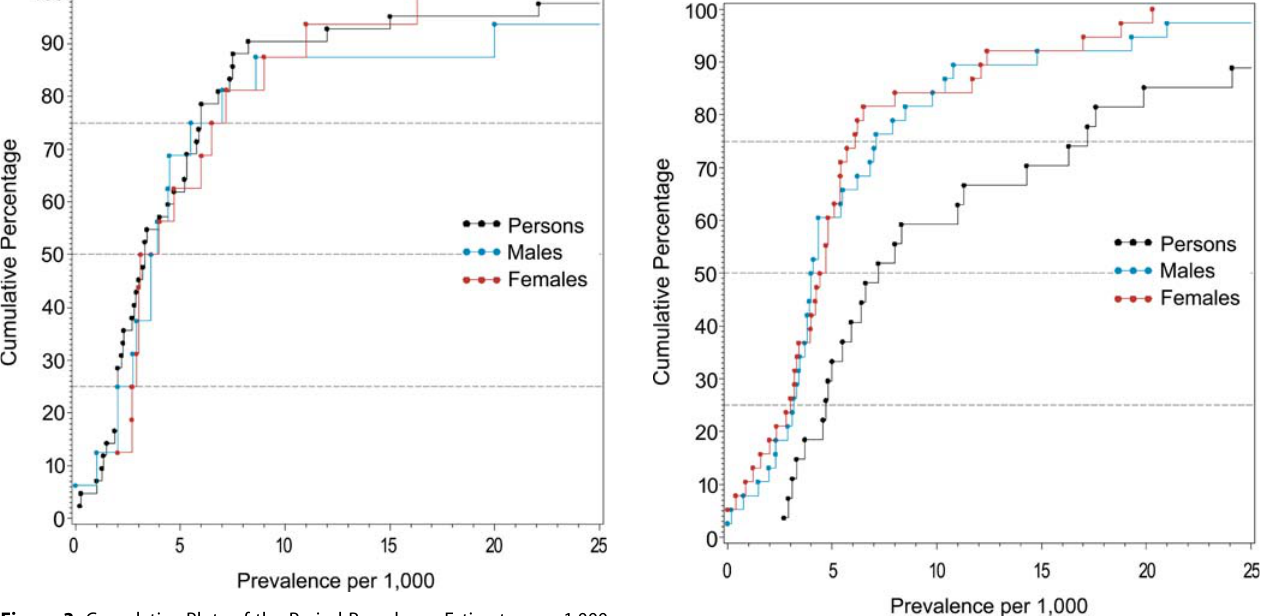
Figure 3. Cumulative Plots of the Period Prevalence Estimates per 1,000 by Sex DOI: 10.1371/journal.pmed.0020141.g003